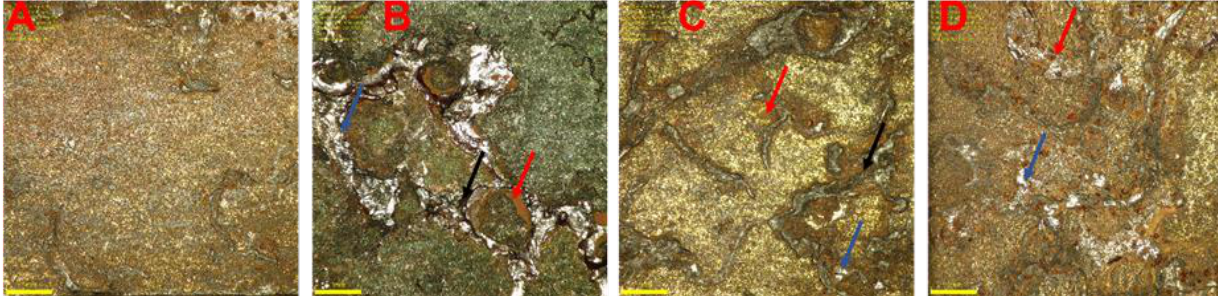
Figure 15. The corroded surface of sample S2 (4% AgNp + CaCO 3 ) in 0.10 NaCl. ( A ) 3 days ( B ) 12 days ( C ) 21 days and ( D ) 30 days.